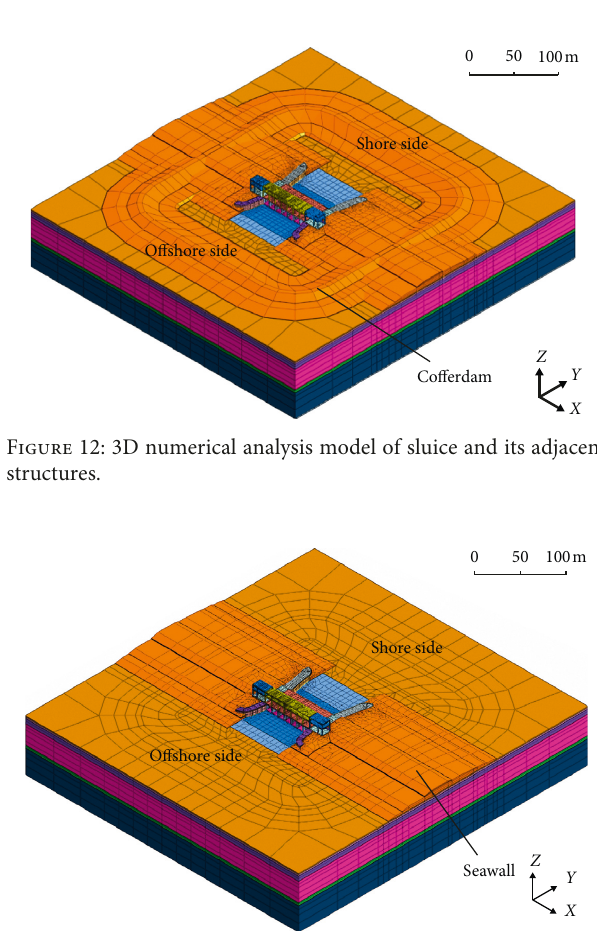
Figure 13: 3D numerical analysis model of sluice and seawall after cofferdam demolition.